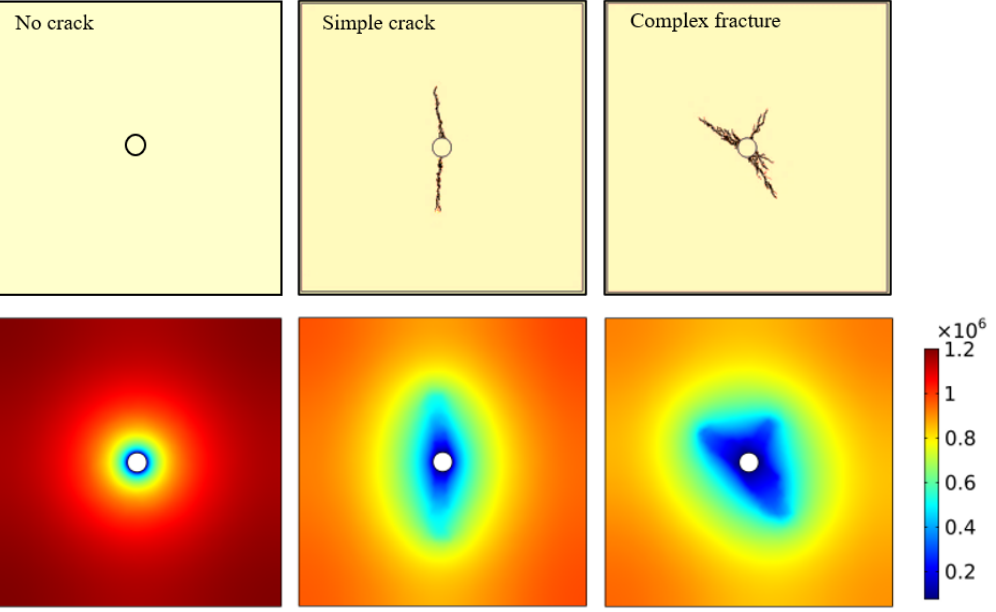
Figure 15. The cloud diagram of the gas pressure distribution considering different crack forms.